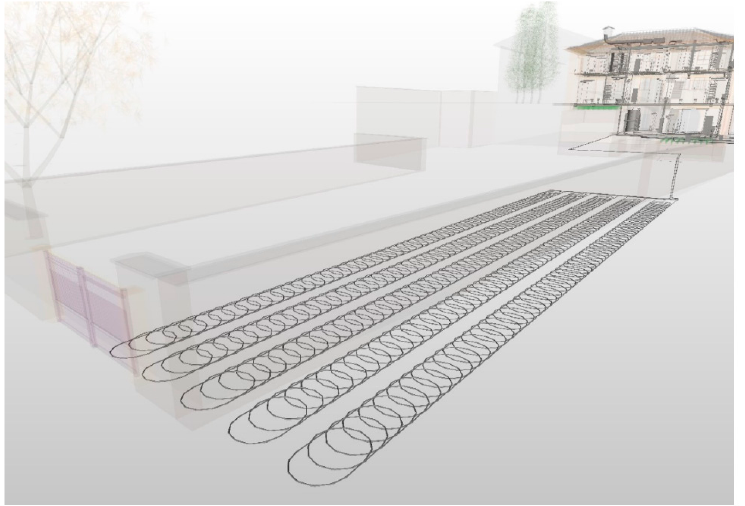
Figure 1. Designed location of the slinky ground source heat exchangers (GHEXs) with respect to the building [10].